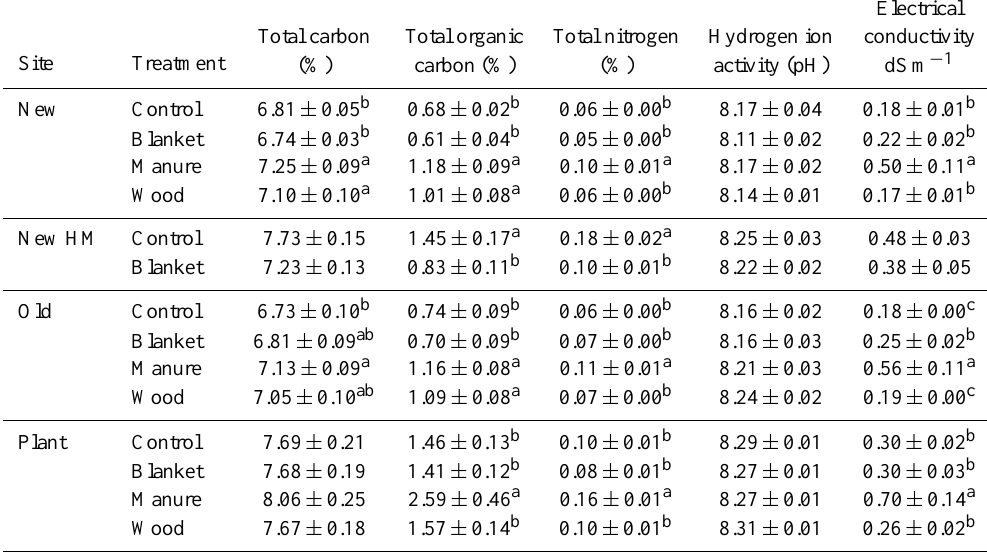
Values are mean ± standard error. Values of ± 0.00 in the table were < 0.006. Letters indicate statistically significant differences among treatments in a site. Absence of letters indicates no statistical differences. Table 5. Mean measured soil properties in soil treatments in 2009.